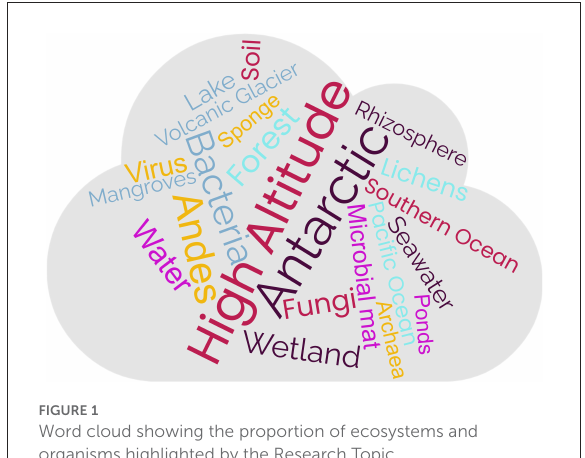
FIGURE1 Word cloud showing the proportion of ecosystems and organisms highlighted by the Research